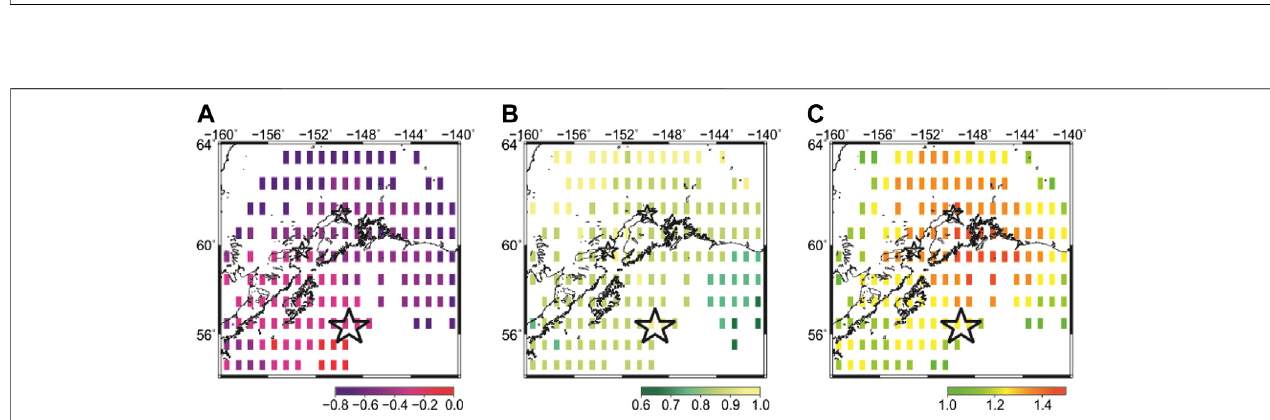
FIGURE 4 | The Uni fi ed Scaling Law for Earthquakes (USLE) coef fi cients in Southern Alaska (Nekrasova and Kossobokov, 2002; Nekrasova and Kossobokov, 2019). Note: stars mark the epicenters of the three major earthquakes.